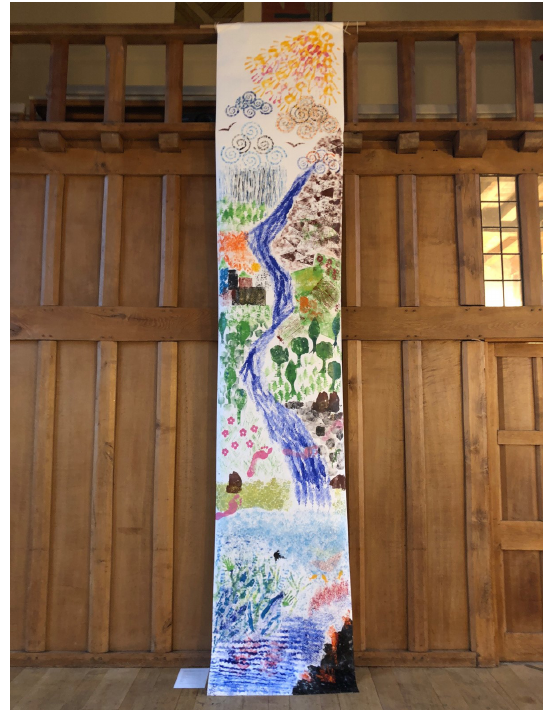
Figure 1. Totem banner – a collective piece of art (Tread Lightly on the Earth) created by participants at the first print-making workshop (Dartington). Photograph: Pierrette